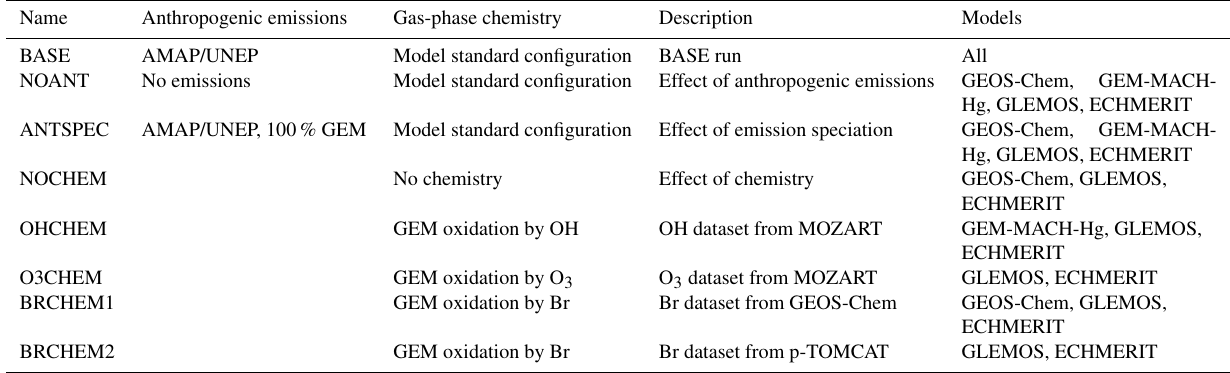
Table 2. Specification of model